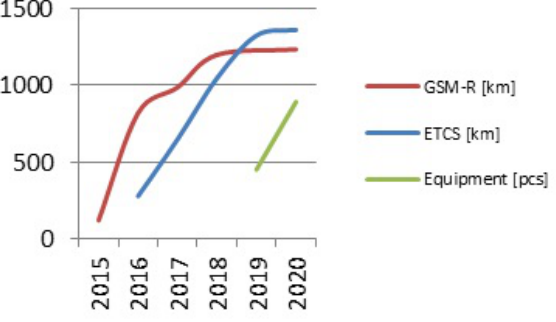
Figure 6. Total amount of expected